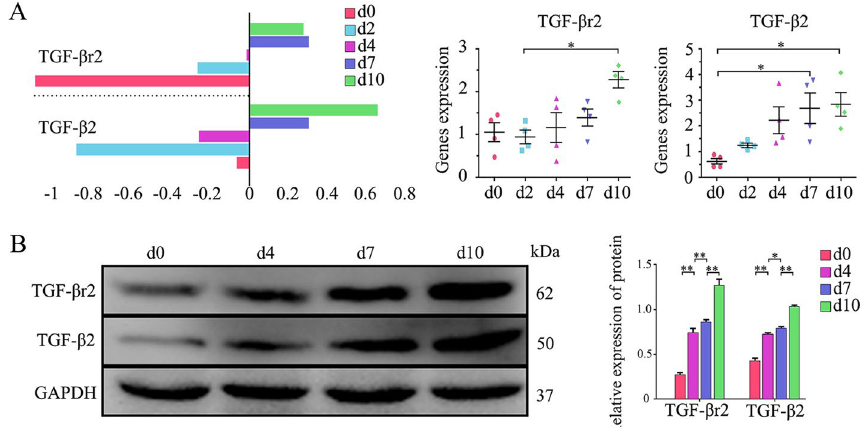
Fig. 1 The expression of TGF-β2 and TGF-βr2 in CTX-injured TA muscle. A RNA levels of TGF-βr2 and TGF-β2 in WT mice injured TA muscle, analyzed by microarray experiment and qPCR. B The protein expression of TGF-βr2 and TGF-β2 in WT mice injured TA muscle, analyzed by Western blot. The relative protein levels are expressed as a ratio (protein of interest/GAPDH). All data are presented as means ANOVA was used for multiple comparisons (* P < 0.05; ** P <